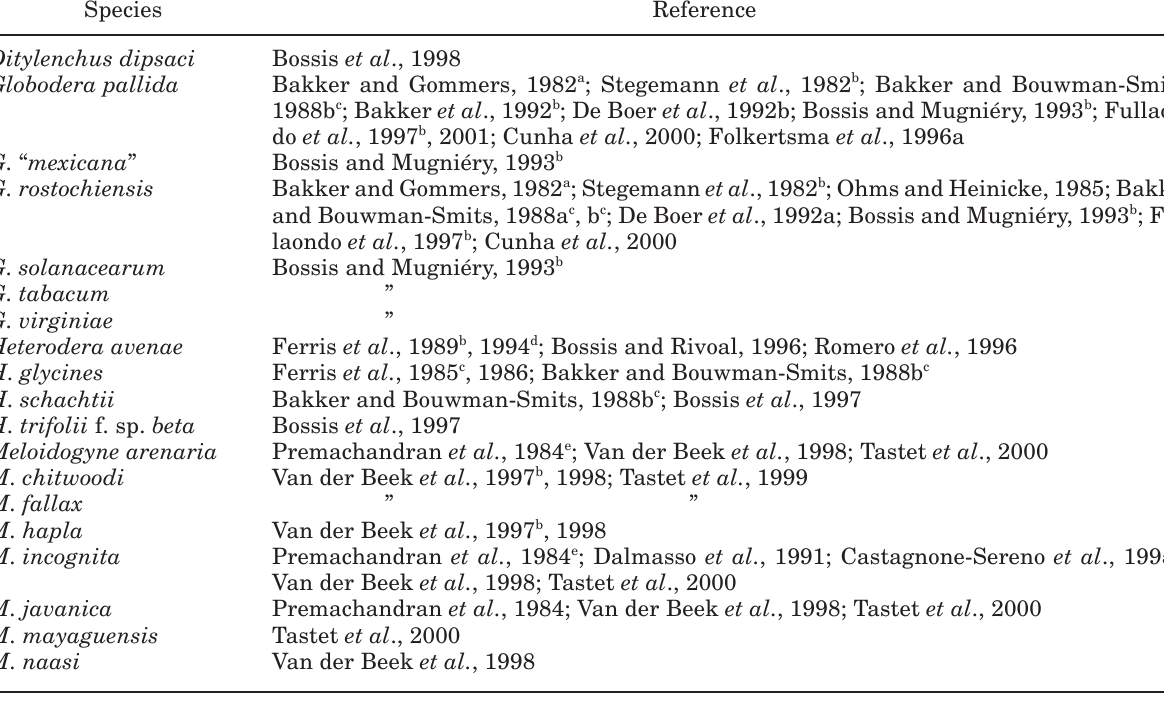
Table 7. Plant-parasitic nematodes species characterized on the basis of proteins, using two-dimensional gel electro- phoresis.